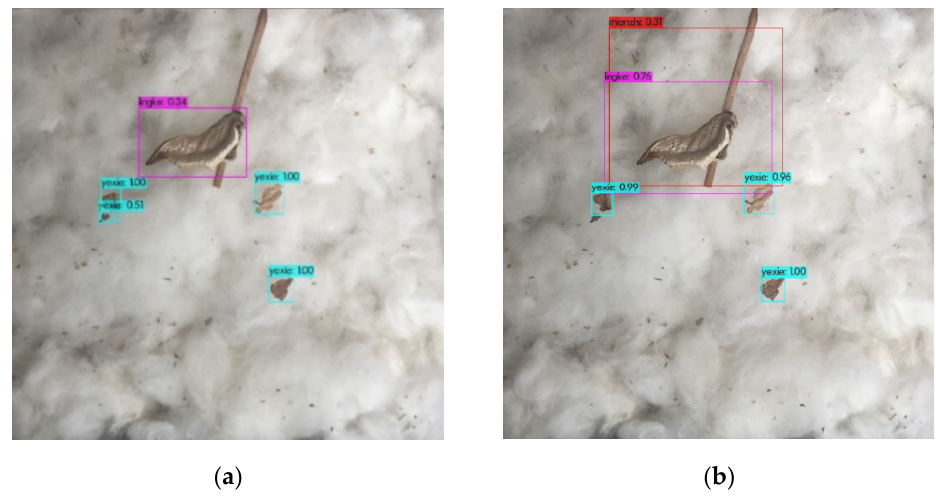
Figure 10. YOLO V4 network model recognition results. ( a ) Recognition result before improvement; ( b ) recognition result after improvement.